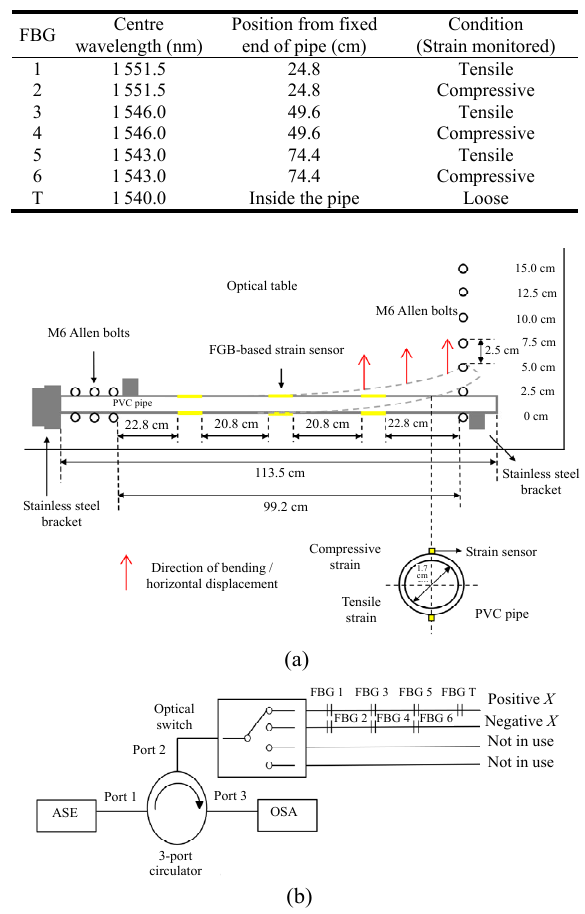
Fig. 5 Illustration of (a) bare and (b) embedded FBGs placement on thermocouple probe, and (c) the setup for temperature characterization